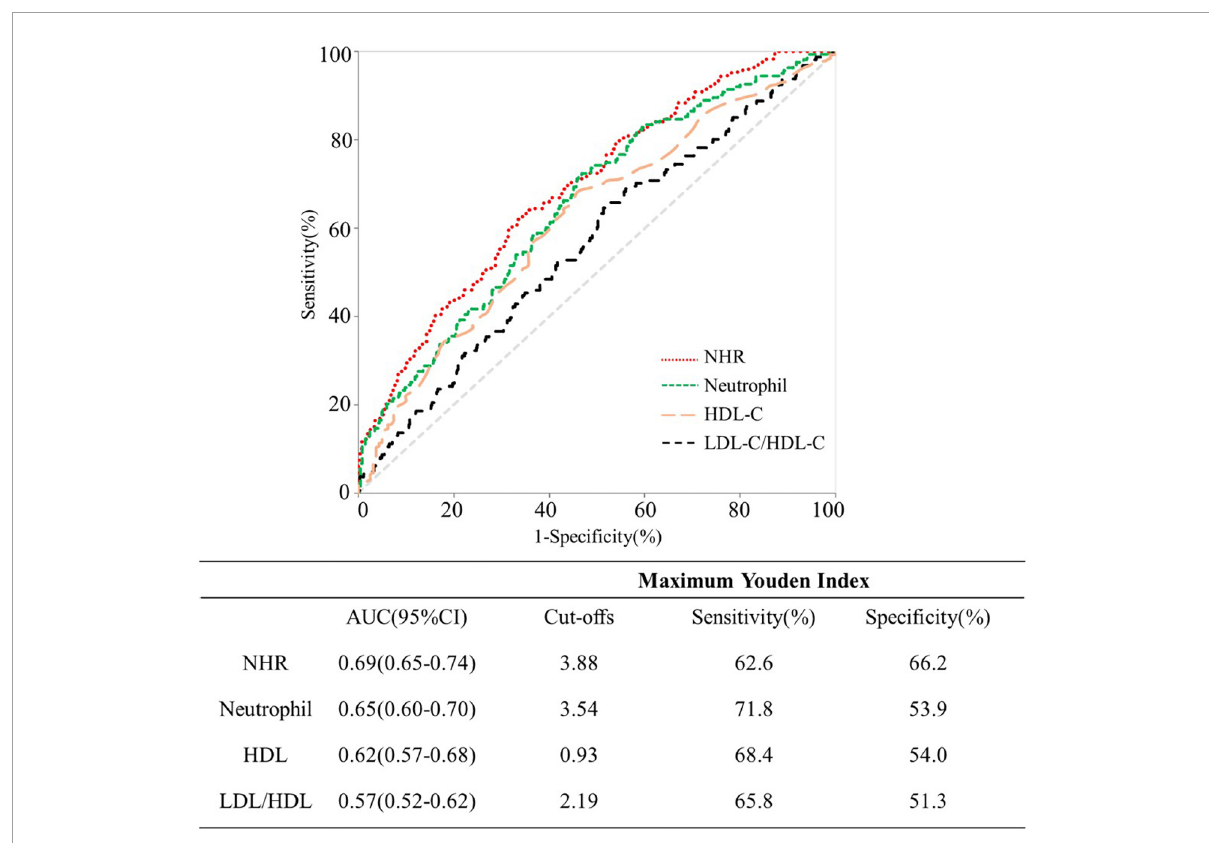
FIGURE3 Receiver operating characteristic curves for predicting severe coronary artery disease